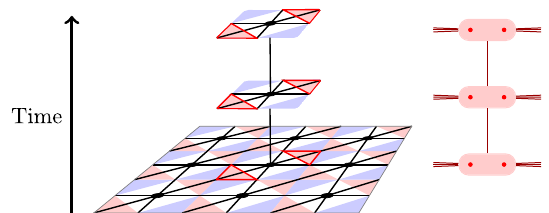
FIG. 8. The 3D X -type matching graph for the subsystem toric code. Left: we show three time steps of the 3D matching graph for a single X stabilizer (highlighted in red), with black lines denoting edges. Right: we also use this more simple, abstract notation to depict the same 3D matching graph in our work, restricted to a single face of the lattice. Here, each pale red rounded rectangle corresponds to an X stabilizer in one of three consecutive time steps in the matching graph. Red dots denote X triangle operator measurements (two of which within a face form a stabilizer), and red lines denote edges in the 3D matching graph.